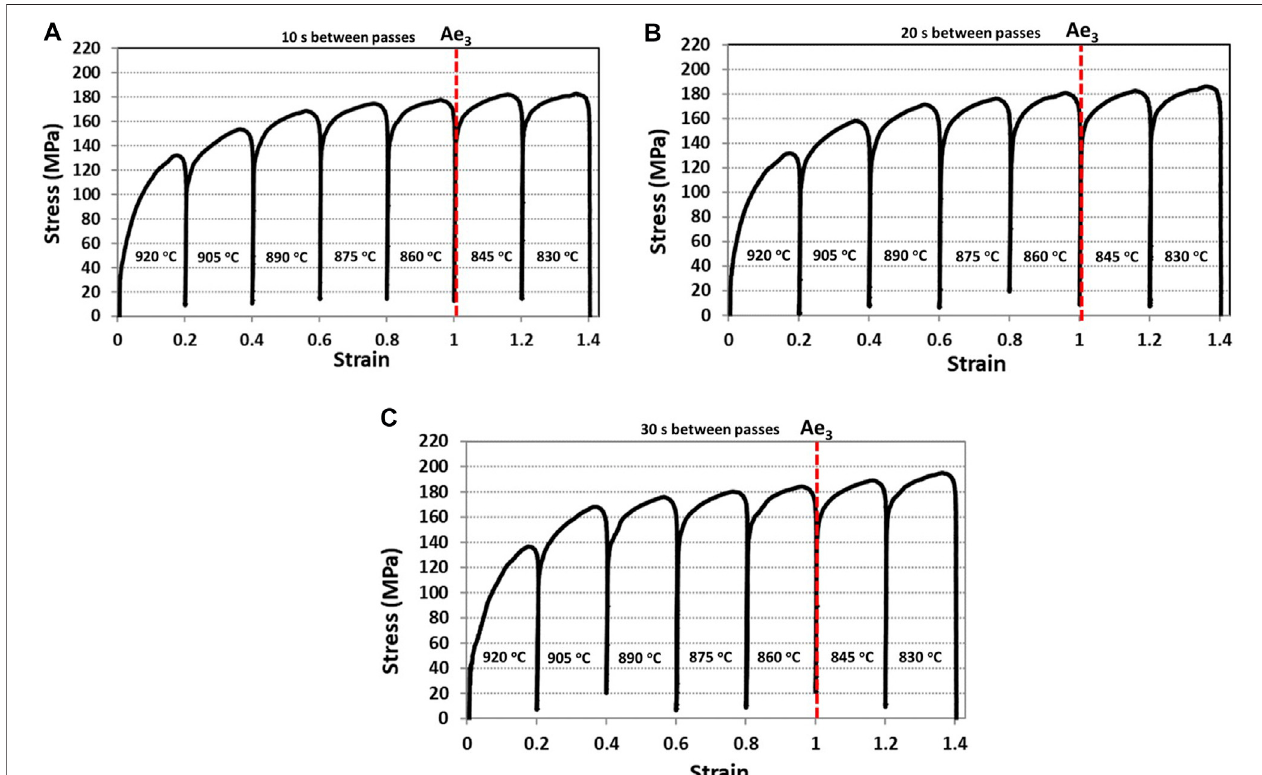
FIGURE 2 | The fl owcurvesofthe seven-pass fi nishing scheduleofthe physicalsimulation ofhot plate rolling withInterpass timesof: (A) 10 s, (B) 20 s,and (C) 30 s.